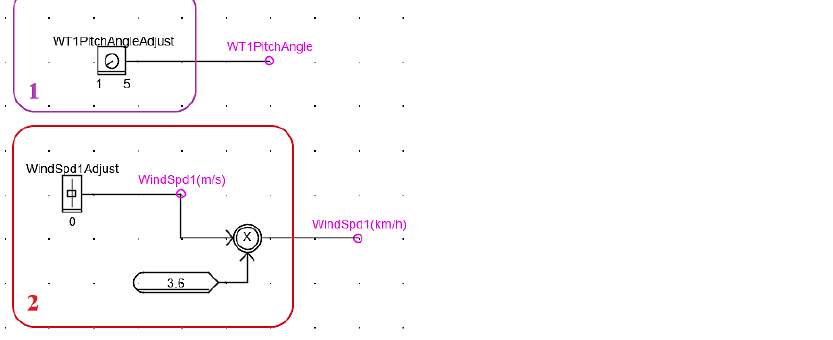
Figure 10. Wind turbine generator blades pitch angle and wind speed adjustment and calculation logic.